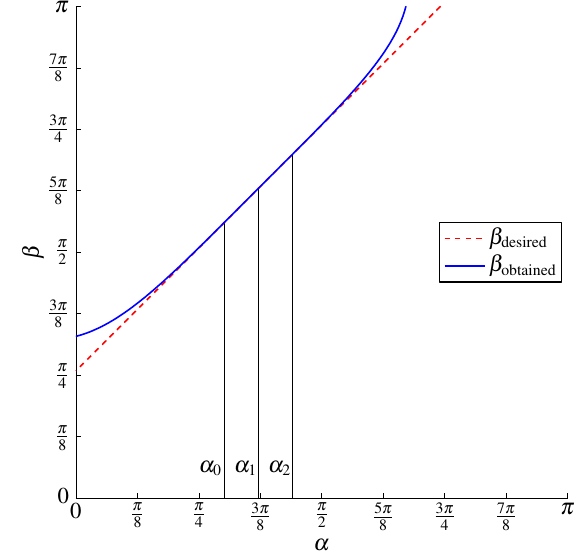
Figure 11. Angle β desired and obtained as a function of angle α with l 1 / r =